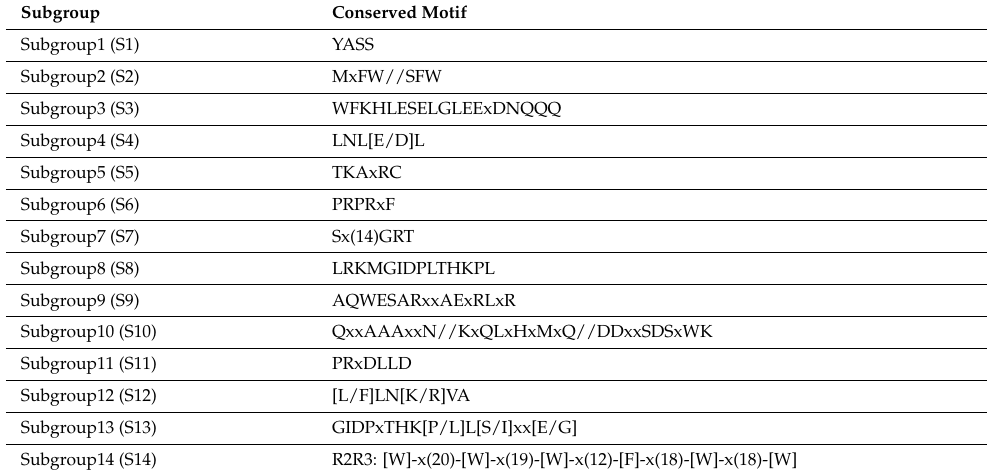
Table 2. Conserved motifs of